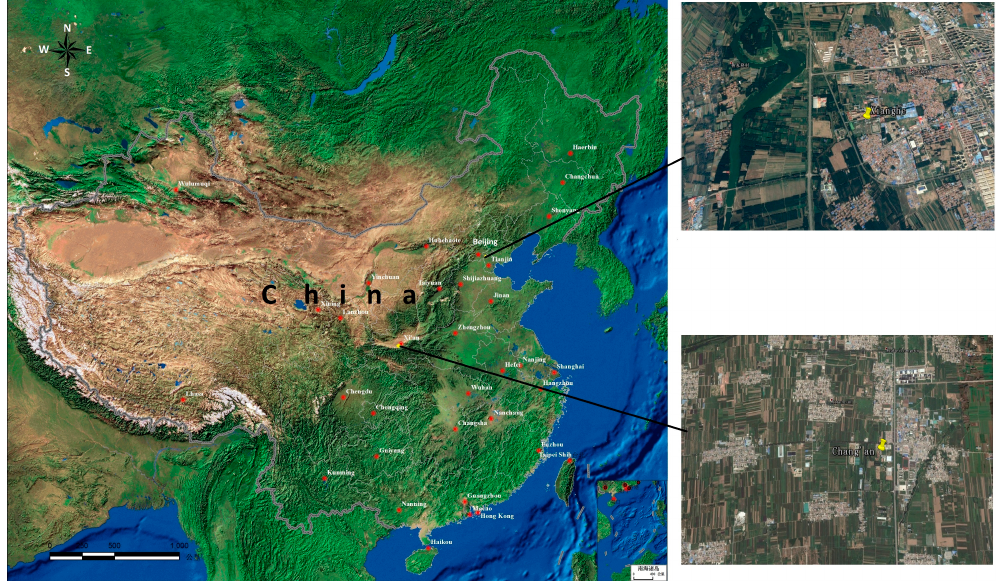
Figure 1. Measurement sites of Xi’an and Beijing (from Google Earth).